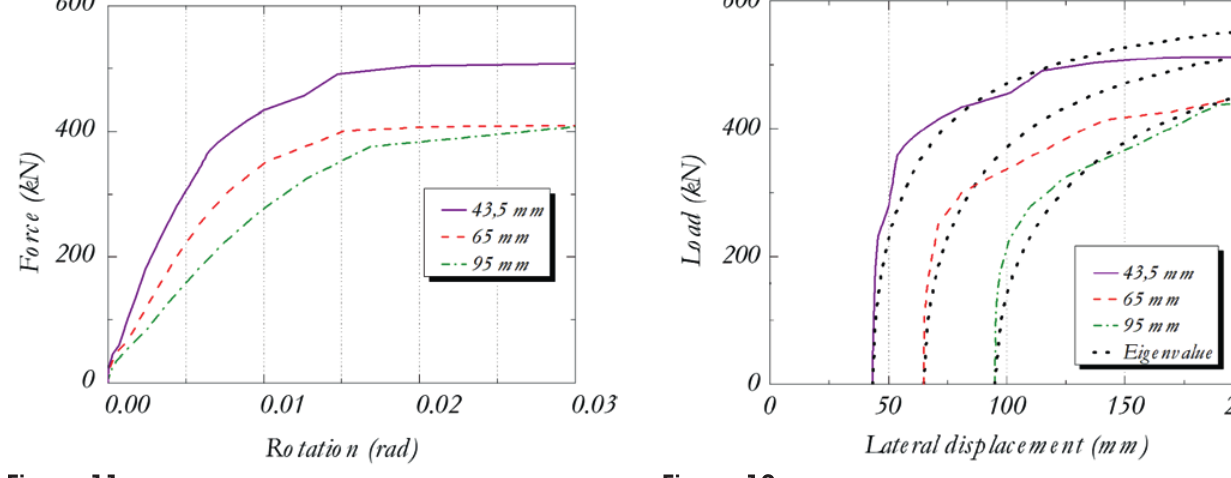
Load-rotation response from geometrical nonlinear analysis